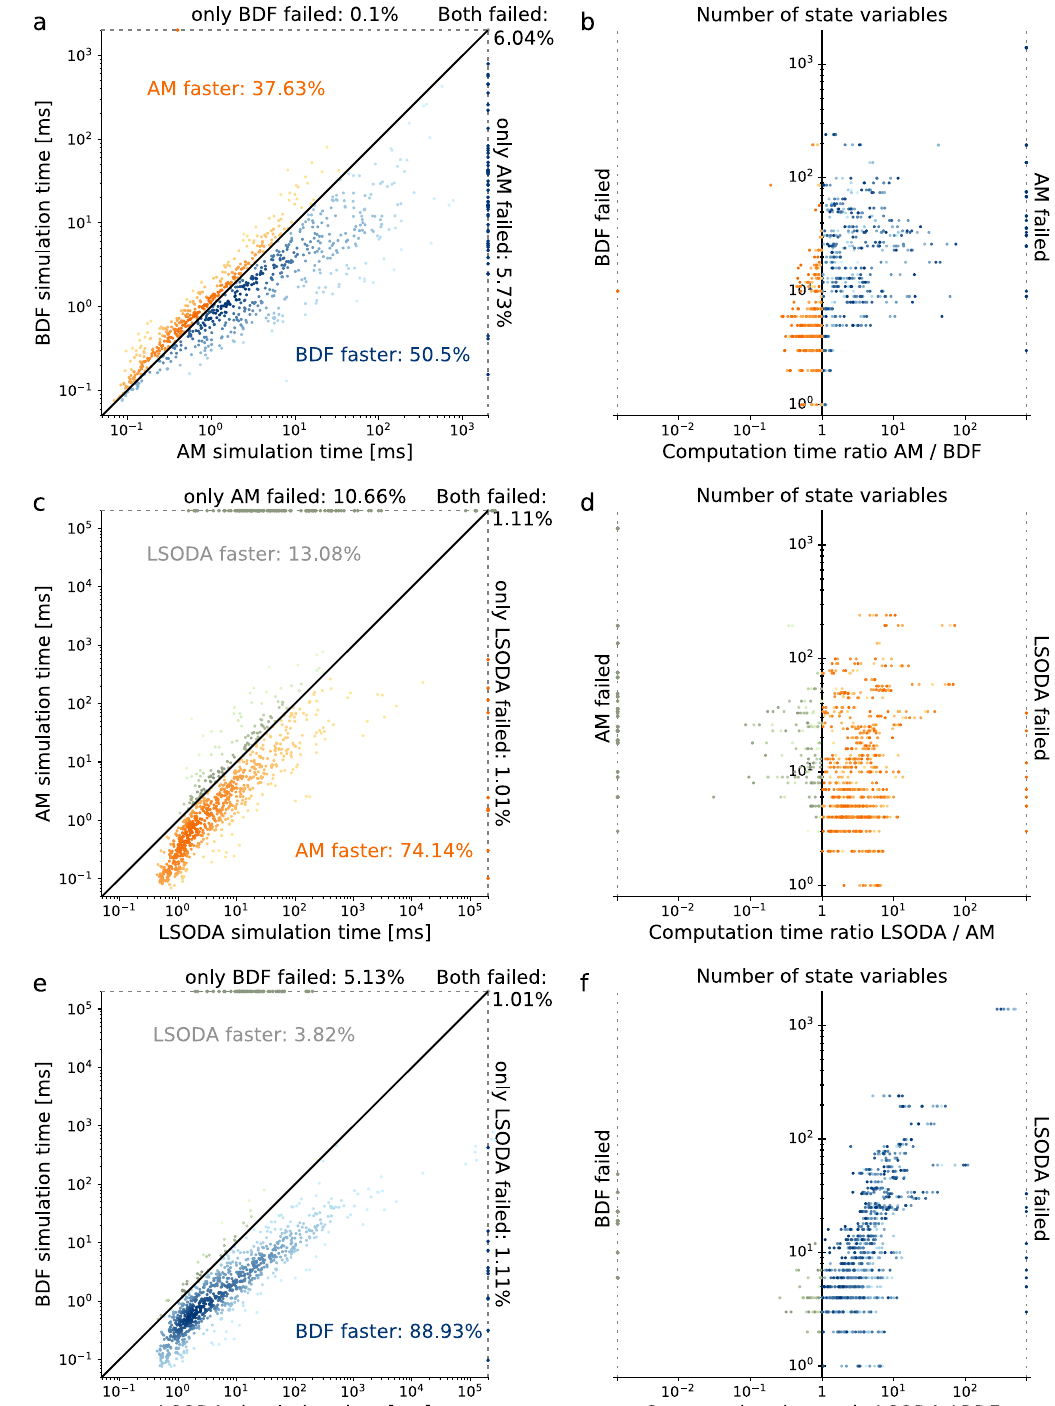
Figure 5. Comparison of integration algorithm ( a ) Each scatter point shows the computation time for a model using the AM (x-axis) or BDF (y-axis) algorithm with the Newton-type non-linear solver, the linear solver KLU and one out of the seven tolerance combinations. Darker colors represent a higher scatter point density. ( b ) Computation time for AM divided by the computation time for BDF with respect to the number of state variables, using the color coding from subfigure A. ( c ) Comparison of the LSODA algorithm (x-axis) with the AM algorithm (y-axis) with the same setup as in a. ( d ) Computation time ratios for the LSODA devided by the AM algorithm, using the color coding from c. ( e ) Comparison of the LSODA algorithm (x-axis) with the BDF algorithm (y-axis) with the same setup as in a. ( f ) Computation time ratios for the LSODA devided by the BDF algorithm, using the color coding from